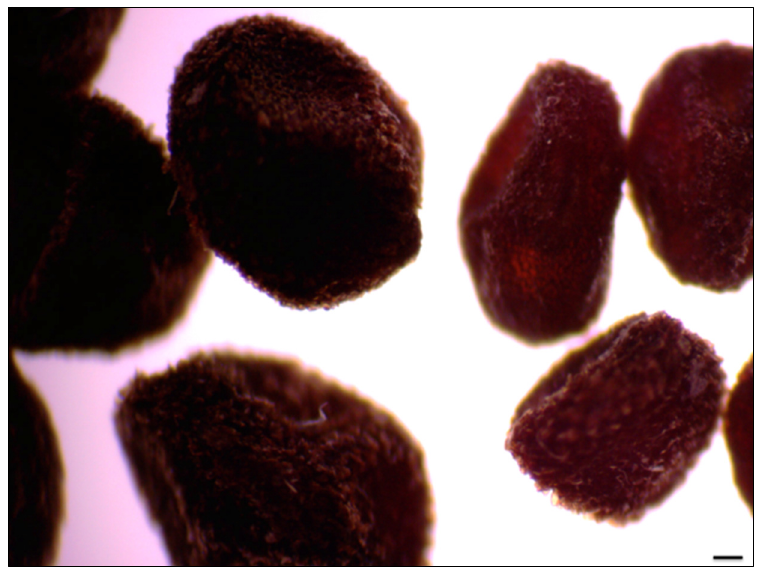
Figure 5. Seeds of P. veris gathered from the ex situ collection (the bigger ones, left) and from the corresponding natural population (the smaller ones, right). Scale bar = 100 µm.